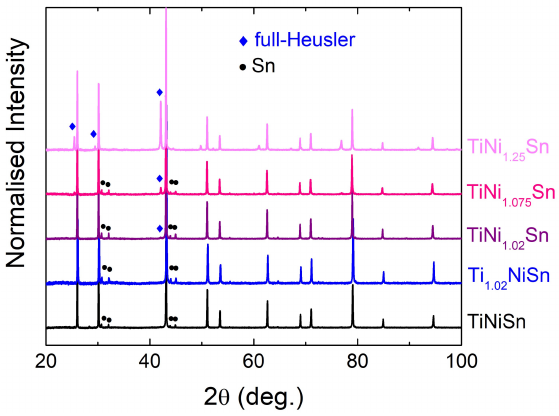
Figure 1. Laboratory X-ray (Cu K α 1 ) powder diffraction patterns for the TiNi 1+y Sn series and Ti 1.02 NiSn. Data are normalised and offset along the intensity axis and plotted against 2 θ